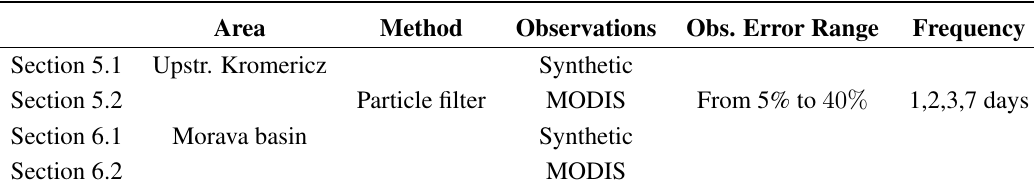
Table 3. Summary of